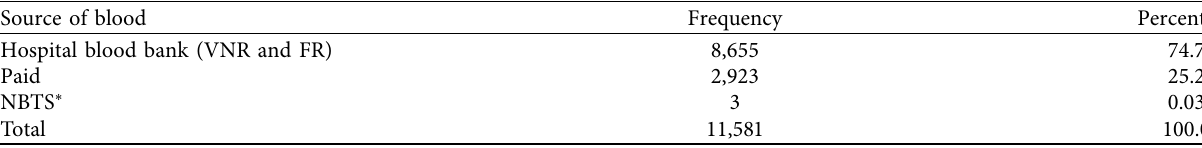
Table 5: Site of blood donation/procurement.